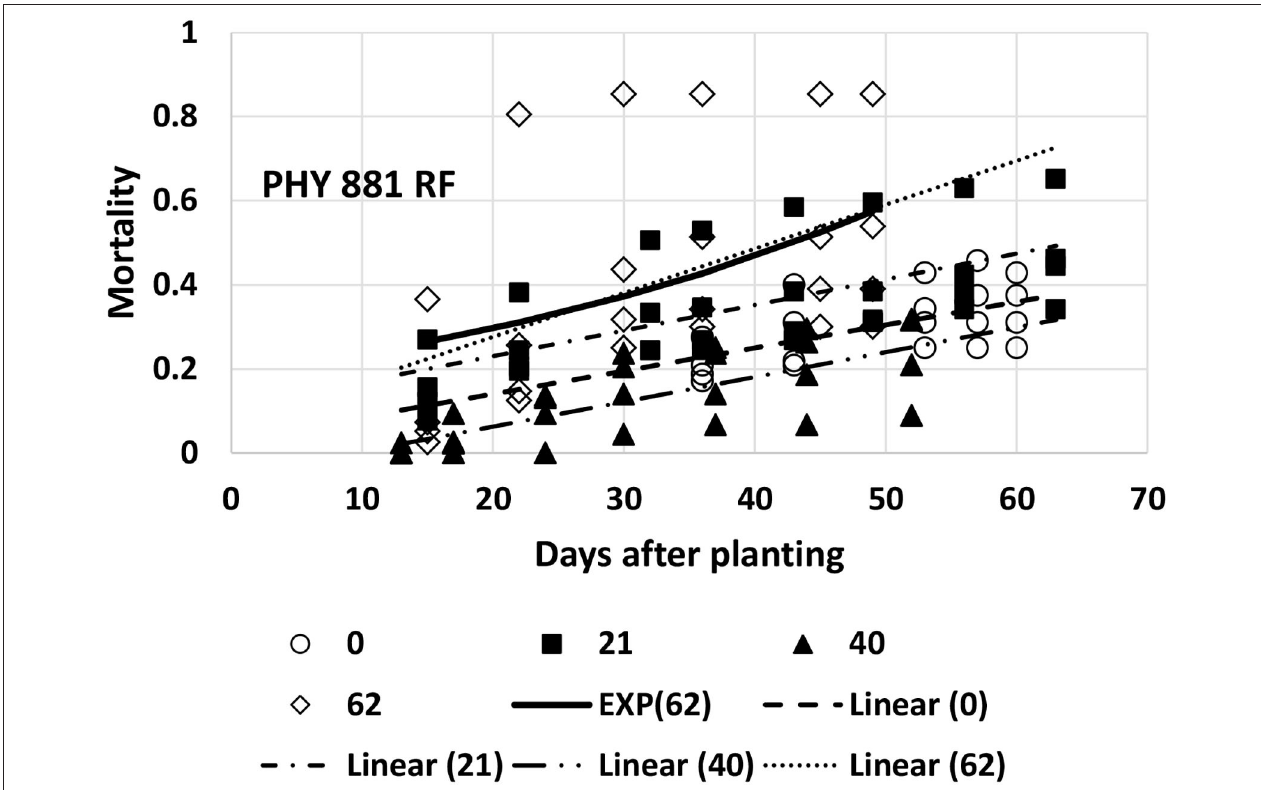
FIGURE 7 | Proportion of plants that emerged and then died (mortality) over time for PHY 881 RF at planting times of day 0, 21, 40, and 62 (day 0 occurred on 16 April). Linear models were fitted for all four dates and are represented as Linear (0, 21, 40, or 62). An exponential model ( Mortality = a × EXP b × T ), where a = 0.188, b = 0.0228, and T = days after planting was also fitted to the last planting date